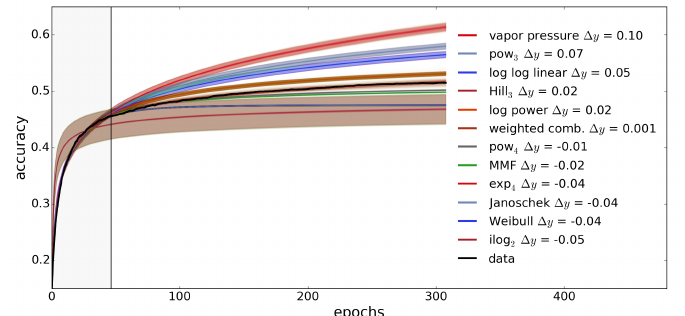
Figure 4. Learning Curve Extrapolation. Best Accuracy Achieved by Algorithm 1.